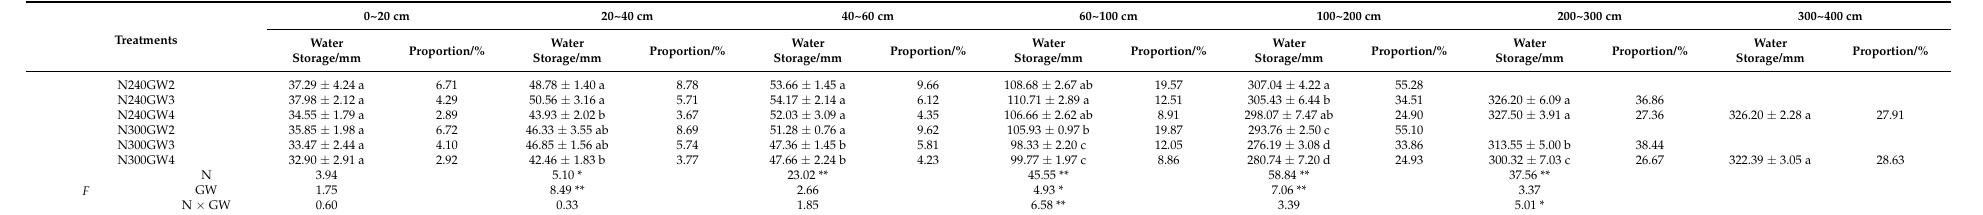
Table 2. Soil water storage in each soil layer in summer maize.